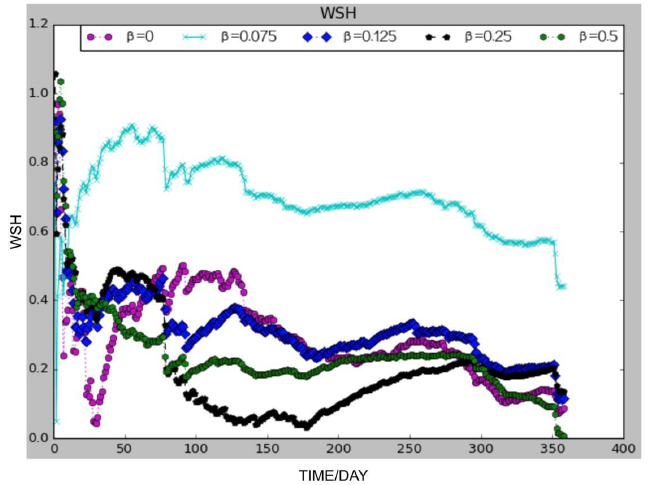
Figure 15. One-year average SQ of optimized evolutionary using different 𝛽 in LD2011_2014 dataset.